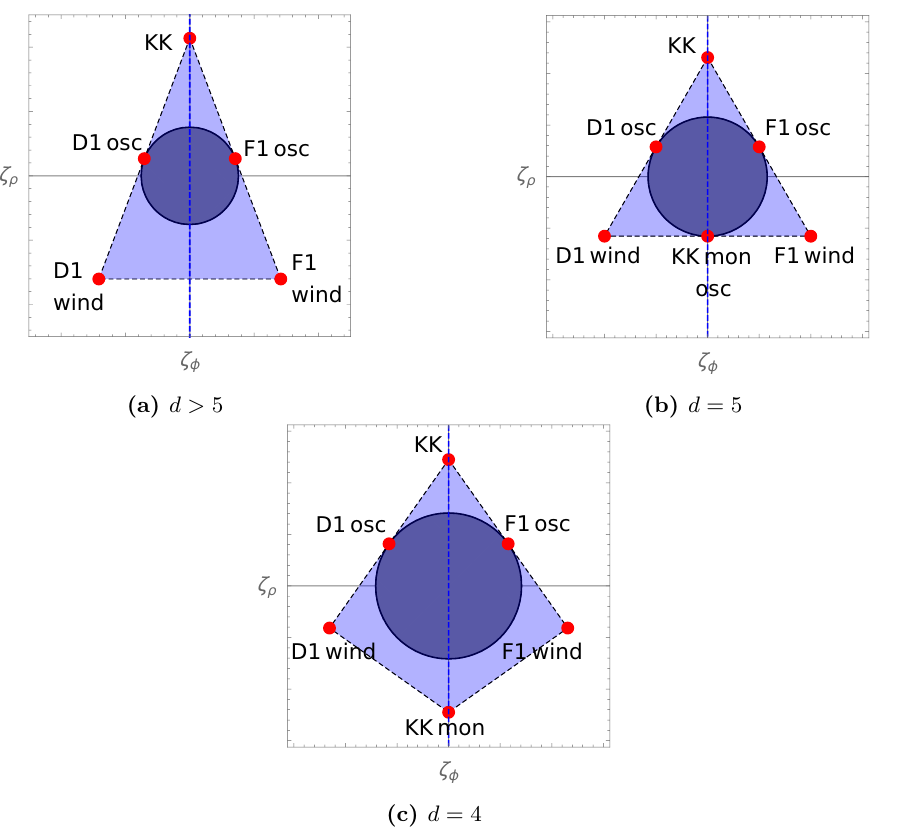
Figure 2. The convex hull condition in a toy model of dimensional reduction. The gray region √ in both figures is the ball of radius 1 / d − 2 centered at the origin. The convex hull generated by the ~ζ -vectors for the Kaluza-Klein modes, the winding string modes, and (in d = 4 dimensions) √ the Kaluza-Klein monopole contains the ball of radius 1 / d − 2 (shown in gray). When the bound √ √ λ lightest = 1 / d − 2 is saturated, so that the convex hull is tangent to the ball of radius 1 / d − 2 , there is always a tower of string oscillator modes (which may come from the monopole string in d = 5 dimensions). Figure adapted from